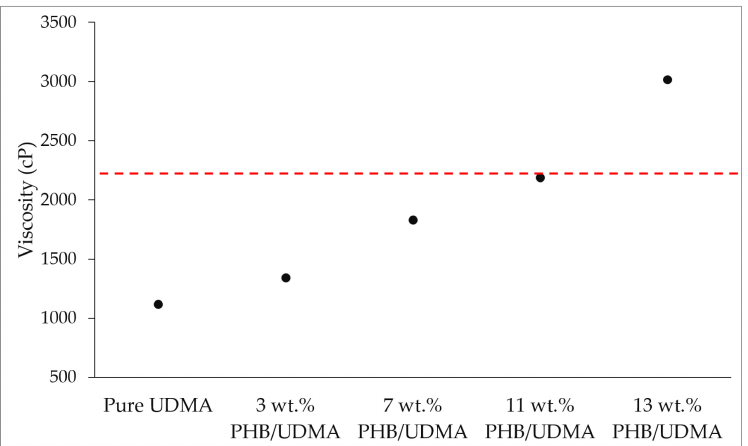
Figure A1. Viscosities of pure UDMA resin and PHB/UDMA resin blends at room